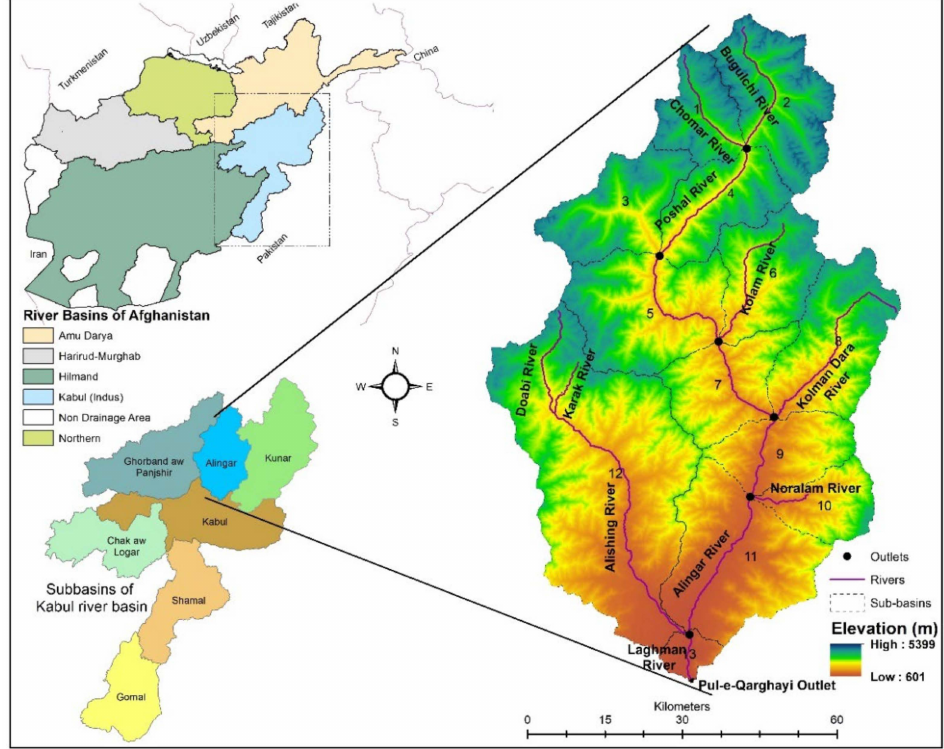
Figure 1. Study area map and river network with their names as well as the delineated sub-basins (numbered